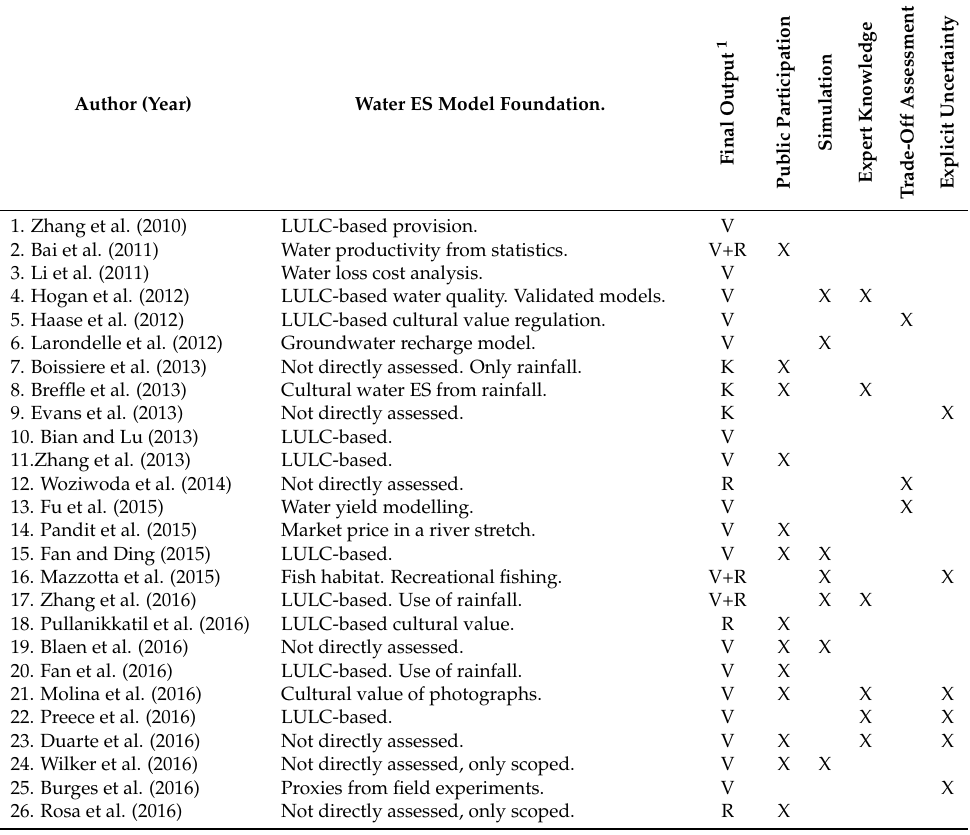
Table A1. Presence of policy-oriented aspects in